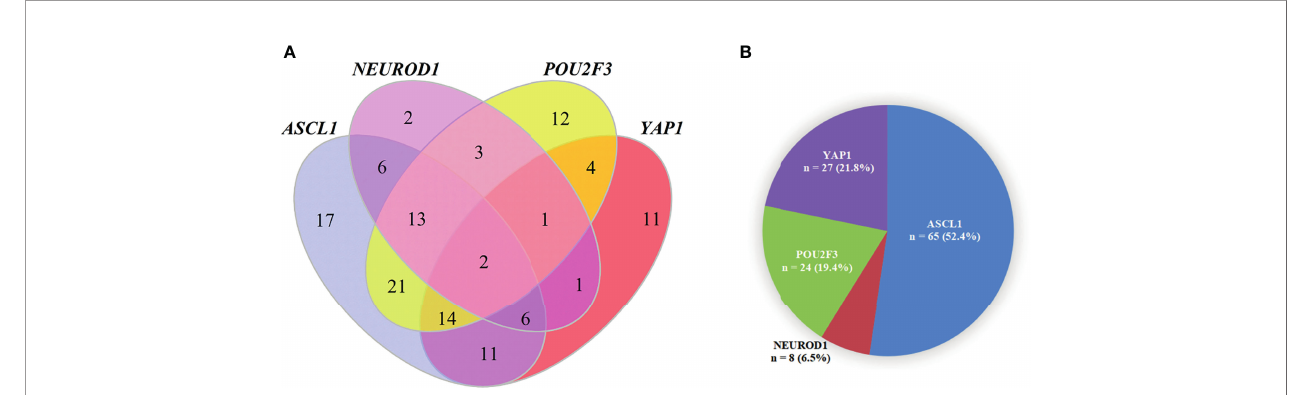
FIGURE 3 | The Pie Chart and Venn Diagram for Subtype Distribution of Primary Small Cell Lung Cancer Tumors. (A) A pie chart illustrating the number and percentage of each dominant molecular subtype tumor (total = 124). Fourteen tumors were excluded in this analysis because of detachment during immunohistochemical staining and a dominant marker is de fi ned as the marker with the highest H-score. (B) Venn diagram illustrating that most SCLC tumors were positive for multiple molecular subtype markers. ASCL1, achaete-scute homologue 1; NEUROD1, neurogenic differentiation factor 1; POU2F3, POU class 2 homeobox 3; YAP1, yes-associated protein